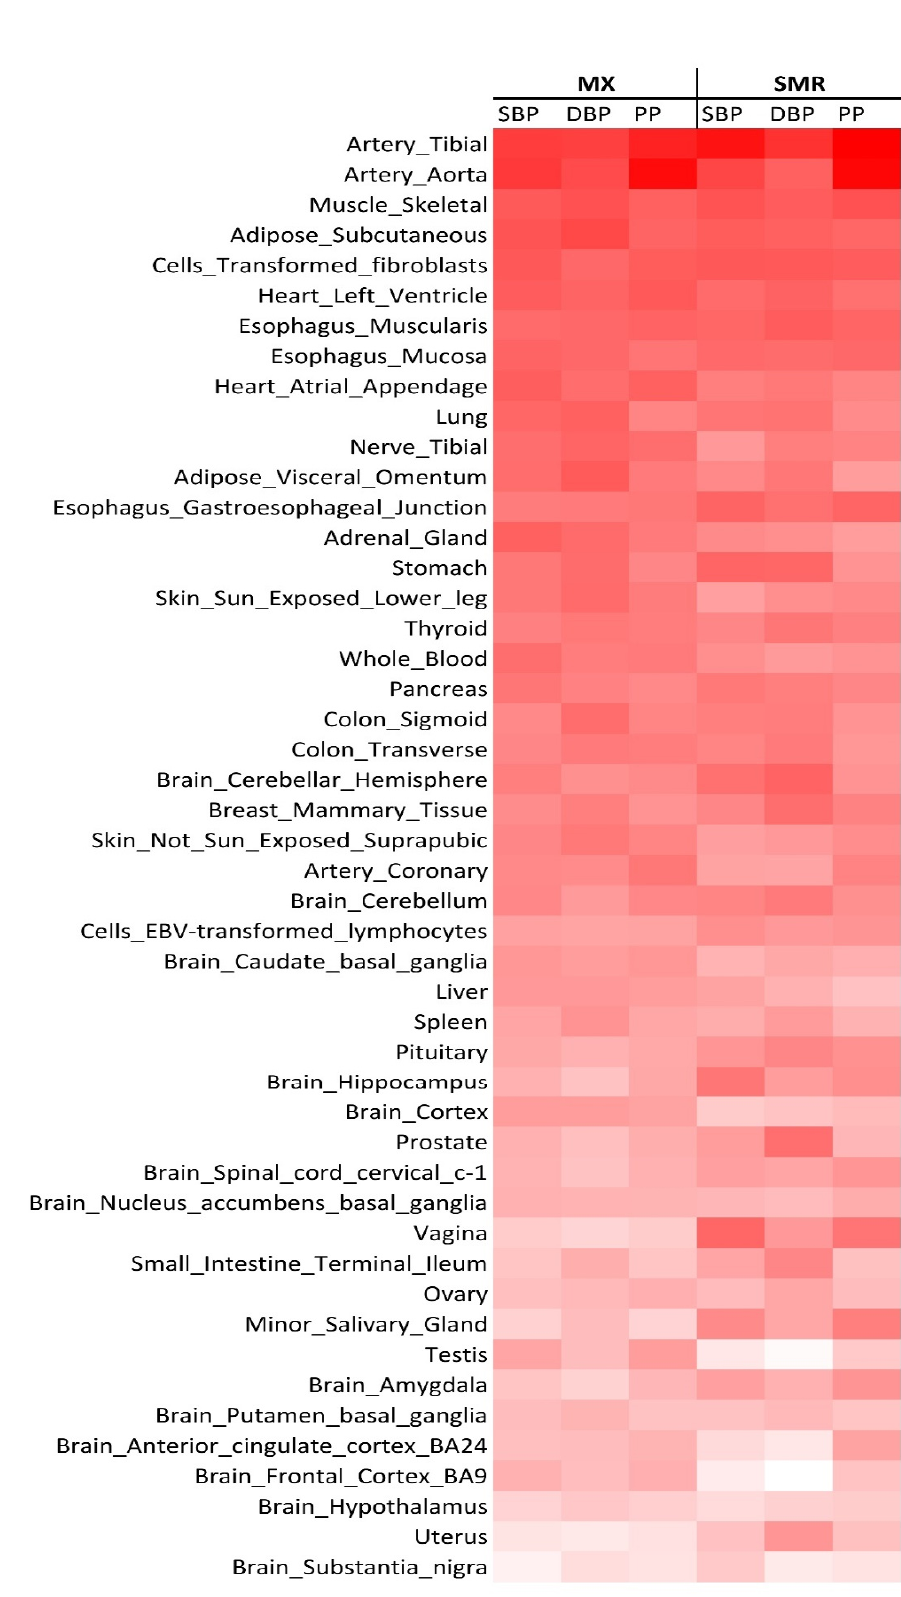
Figure 3. Average Z squares of the genes’ associations with BP traits across 48 GTEx tissues using both MetaXcan (MX) and summary data-based MR (SMR) TWAS. Colour intensity set to higher values. The order of tissues is based on the mean of the average Z squares of the genes across BP traits and the two TWAS approaches.